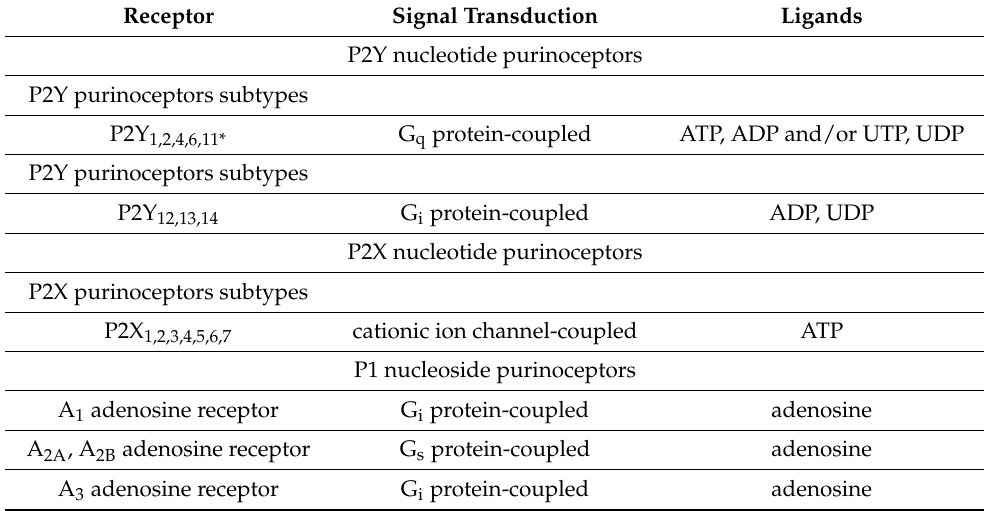
Table 2. Purinoceptors, their signal transductions and endogenous